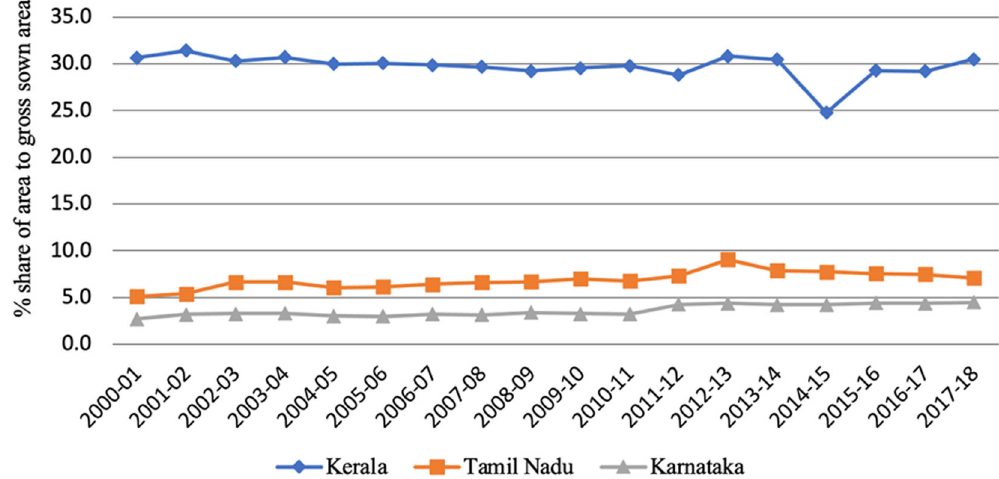
Fig. 2 Contribution of coconut in the gross sown area (GSA) in selected states. This graph shows the percentage share of area devoted by Kerala, Tamil Nadu and Karnataka for coconut cultivation to each state ’ s gross sown area during the agricultural years under consideration (Source: calculated based on data retrieved from Coconut Development Board and Reserve Bank India).